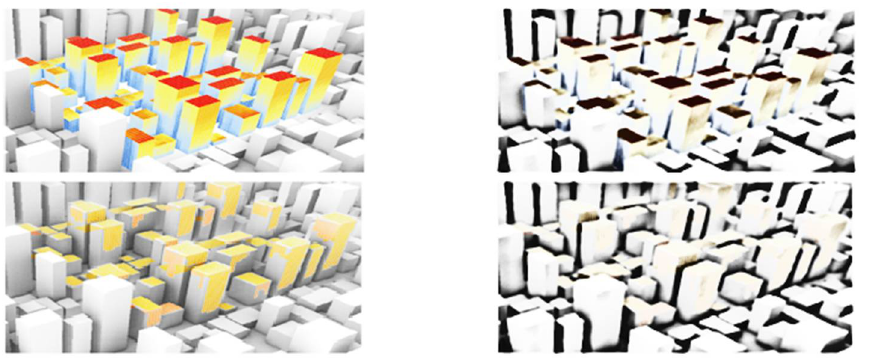
Figure 9. Radiation analysis, meshing and calculation of average annual radiation (upper) defining the installation boundary based on thresholds (lower) [50].